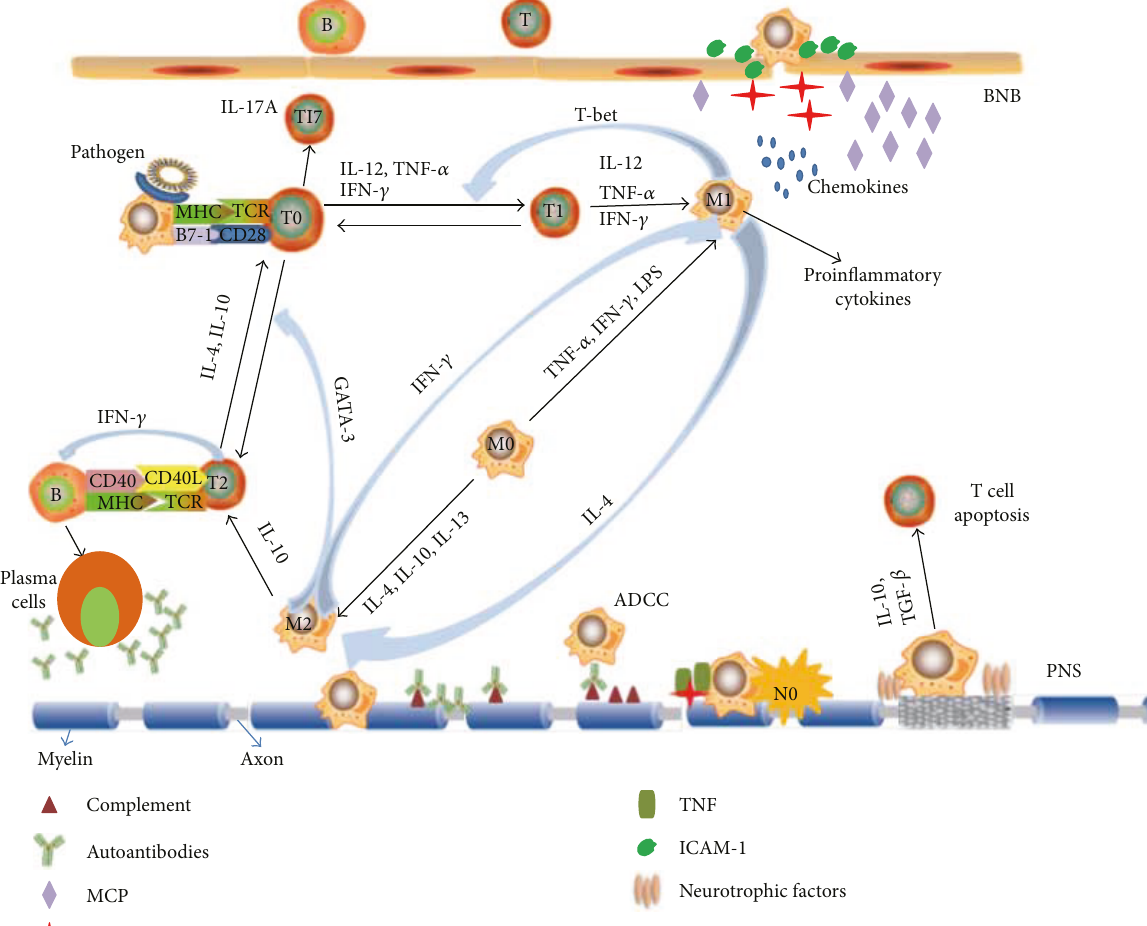
Figure 1: Role of macrophages in the pathogenesis of EAN. Macrophages as the main professional antigen-presenting cells (APCs) by expressing MHC and costimulatory B7-molecules promote the polarization of T cells. Polarized Th1 cells drive macrophages to express a proin fl ammatory phenotype (M1). Proin fl ammatory cytokines from M1 macrophages in turn promote the Th1 responses via GATA-3 transcription, while anti-in fl ammatory cytokines from M2 macrophages facilitate the Th2 response via T-bet transcription. During disease progression of EAN, M1 macrophages contribute to breakdown the blood-nerve barrier (BNB) by releasing adhesion molecules, matrix metalloproteases (MMPs), and chemokines. Macrophages can directly attack myelin or indirectly cause demyelination by antibody-dependent cellular cytotoxicity (ADCC) or complement-dependent manner and releasing proin fl ammatory cytokines. In addition, nerve destruction occurs through nitric oxide (NO), MMPs, and other cytotoxic radicals. In the recovery phase of EAN, M2 macrophages contribute to remyelination and tissue repair through secreting anti-in fl ammatory cytokines such as IL-10 and tumor growth factor (TGF- β ) and promoting T cell